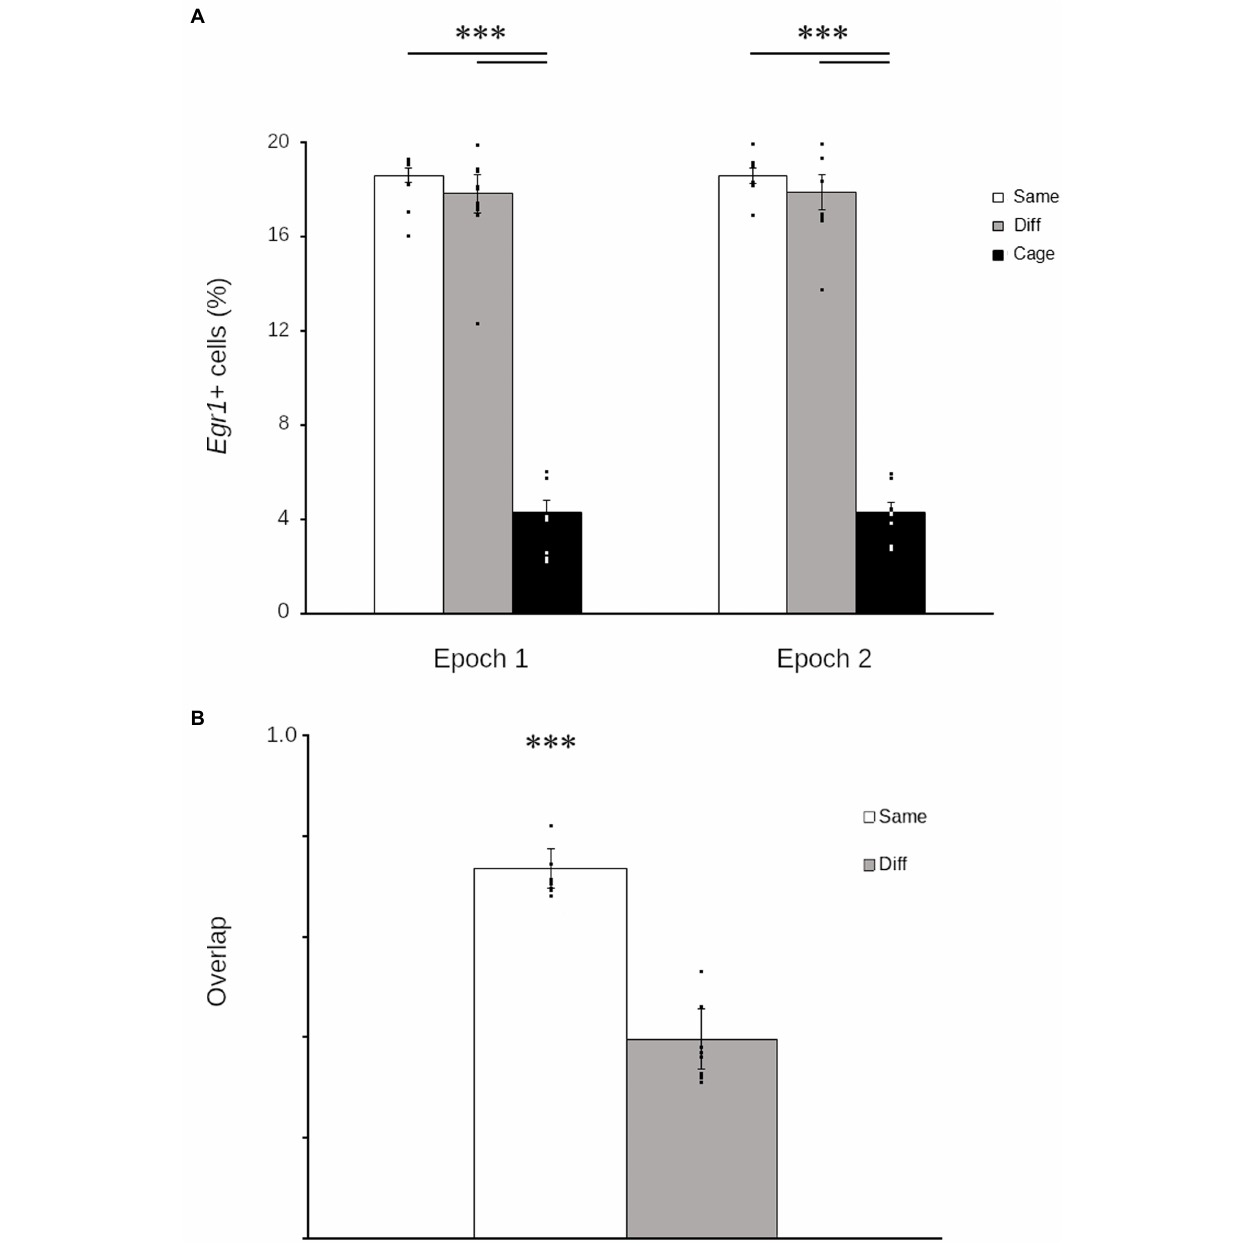
FIGURE 2 | Hippocampal Egr1 expression is context-specific in Japanese quail. Graphs of Egr1 expression during each epoch (A) show that quail that explored either the same environment repeatedly (white) or two different environments (grey) both expressed Egr1 in significantly more cells than quail that remained in the housing room (black). Similarity scores (B) show that the proportion of cells that repeatedly expressed Egr1 across both explorations was significantly higher in birds that explored the same room twice (Same: white) relative to birds that explored different rooms (Different: grey). Data are means ± SEM (*** p < 0.001). Individual data points are for each quail are superimposed on each